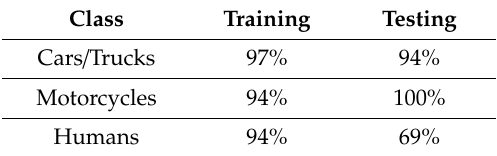
Table 9. Humans and vehicles, in 2 classes, training and testing prediction accuracy.